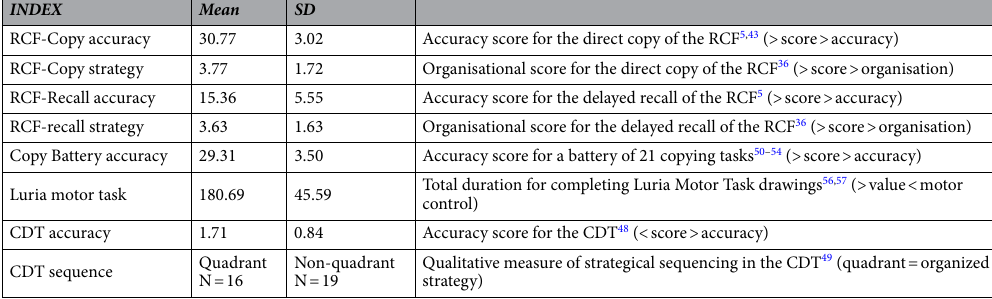
Table 1. Descriptive statistics (mean, and standard deviation) for each measure included in the drawing battery. For RCF-copy scores, N = 97; for other scores, N = 35. SD standard deviation, RCF Rey Complex Figure, CDT Clock Drawing